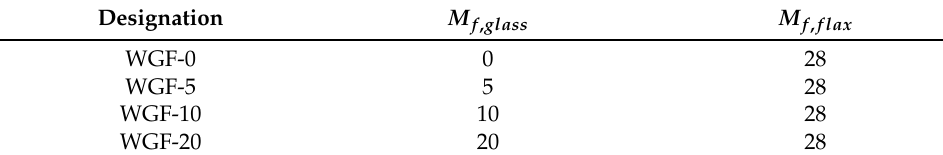
Table 1. Composition of composites with WGF.